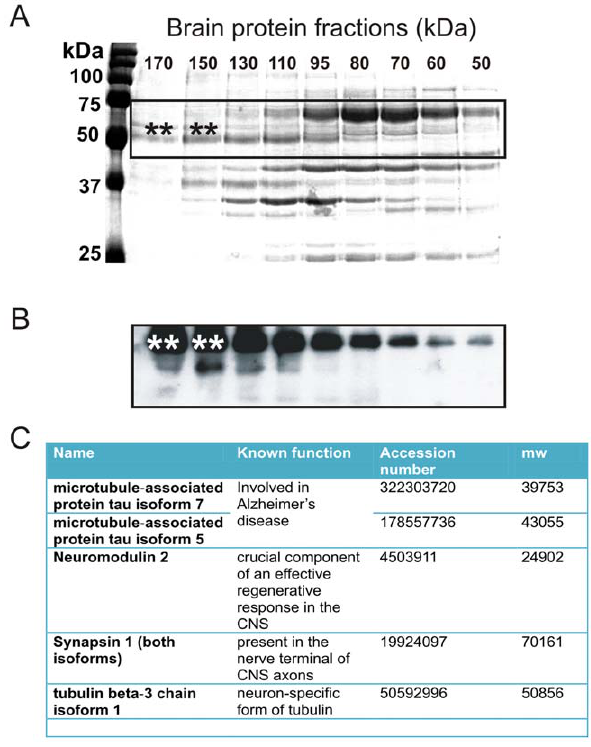
Figure 7. FPLC-Western Blot and Mass spectroscopy screening of auto-Ab candidates. A ) Control human brain protein content was fractioned by molecular weight using FPLC. Fractions between 170 and 50 kDa are shown on a polyacrilamide gel (15% SDS) to further separate proteins by molecular weight. This two-step technique allows for a comprehensive separation of the total brain protein content. B ) A parallel gel was run and processed for western blot analysis with player’s serum (highest measured auto-S100B antibody, # in Figure 4) used as a ‘‘primary’’ antibody. Bands of interest ( double asterisks ) were excised and processed for MS analysis. Results are shown in the Table ( C ) and described in the text.